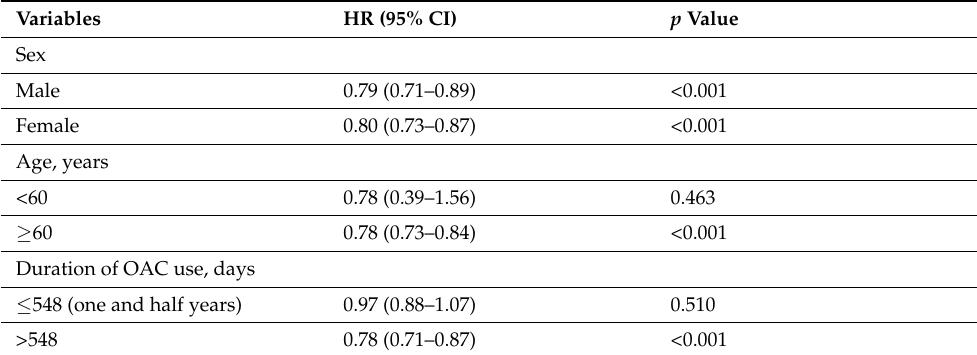
Table 4. Relative risk of osteoporosis in patients treated with DOACs versus warfarin based on sex, age, and treatment